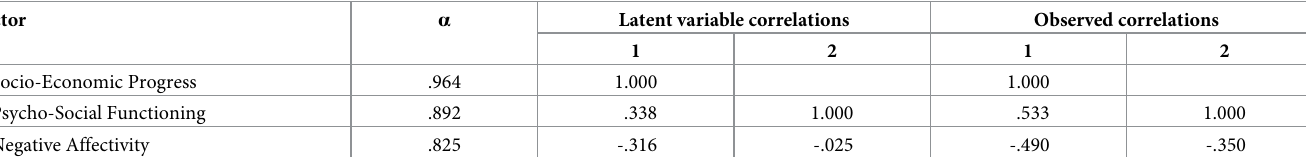
composite variables) and averaged to form three higher-level variables of Socio-Economic Progress, Psycho-Social Functioning, and Negative Affectivity. The Socio-Economic Progress score was calculated for nations with a single missing value as well. As shown in Table 5, observed correlations are stronger than latent correlations. In general, however, the correla- tions are modest, suggesting that a country’s standing on one of the dimensions does not strongly predict its standing on other dimensions. S1, S2 and S3 Figs in the supplementary material show the pairwise relationships between the variables. A three-dimensional scatter- plot is shown in Fig 1. Cronbach’s alphas for each of the three variables based on the